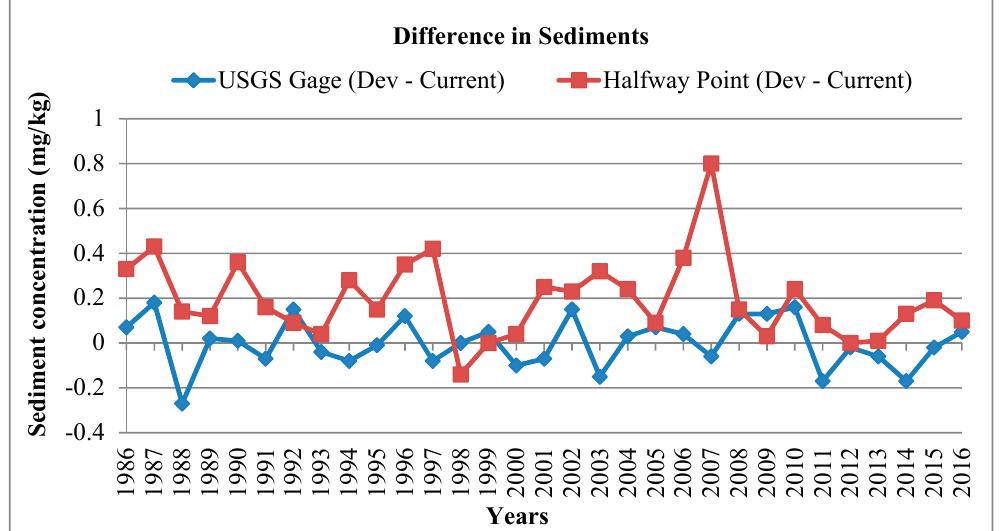
Figure 7. Difference in sediment concentration between Current and Developed scenarios, at Figure 7. Di ff erence in sediment concentration between Current and Developed scenarios, at Watershed Watershed Halfway Point and USGS Gaging Station, from uncalibrated SWAT model iterations. Halfway Point and USGS Gaging Station, from uncalibrated SWAT model